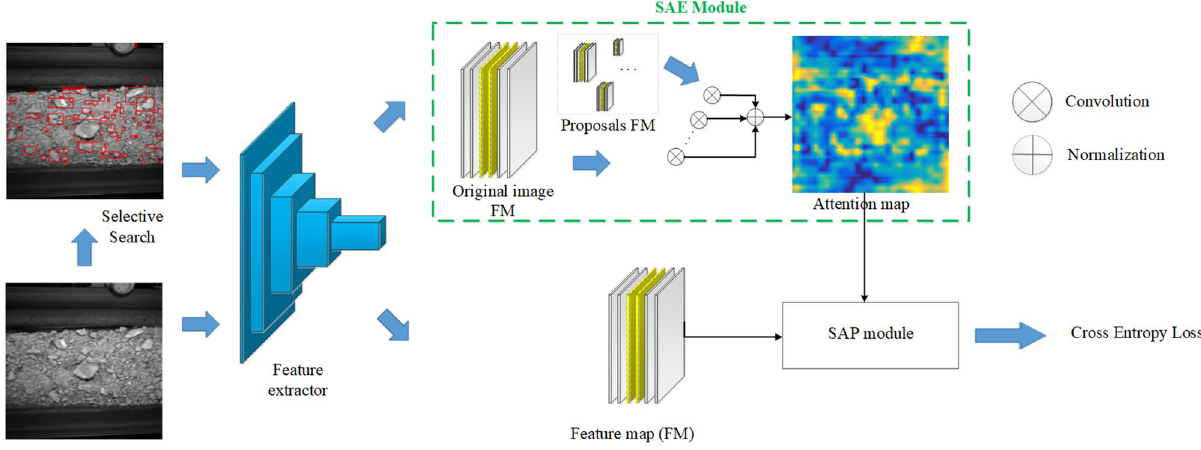
Figure 4. Illustration of the overall